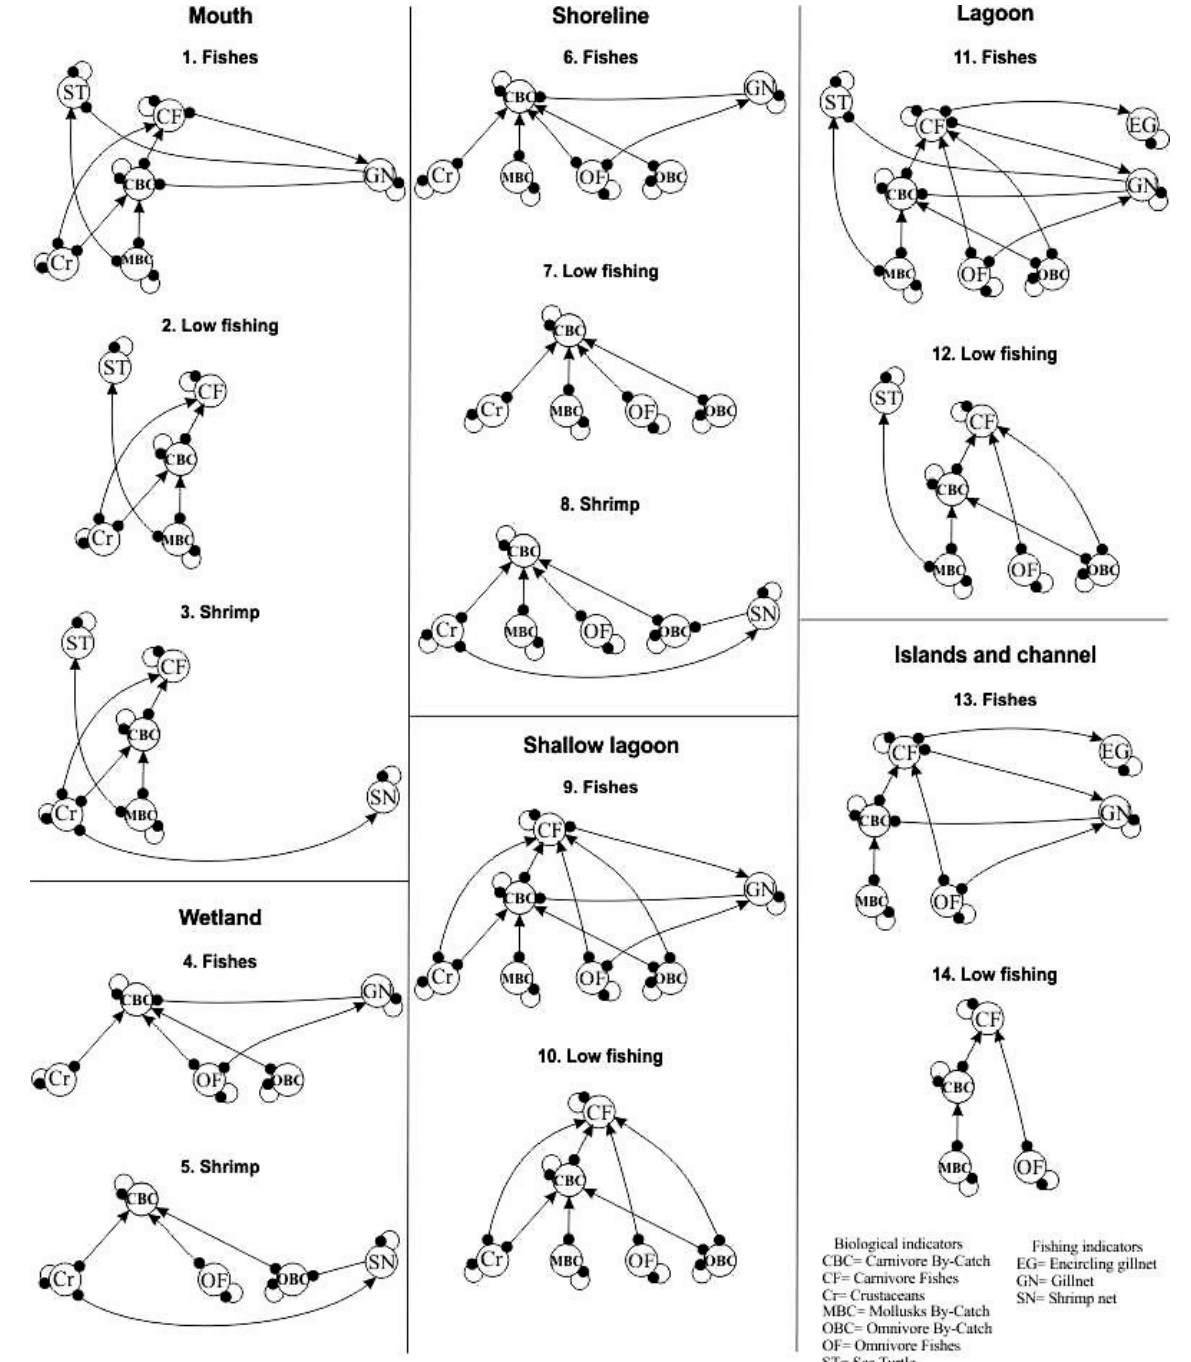
Fig. 6 . Alternative models generated for the Huave Lagoon System, Mexico. The combination of fishing seascapes, and fishing seasons, yielded 14 alternative models. Example: Model “Mouth: 1. Fishes” represents the first model from fishing seascape “mouth,” where carnivore fishes are harvested. Temporal fishing seasons are denoted by their names, model “fishes” represents the harvest that takes place from March to April and from August to